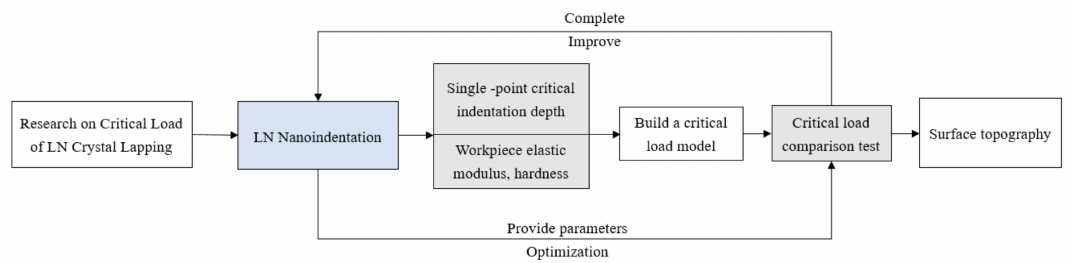
Figure 1. Flow chart for